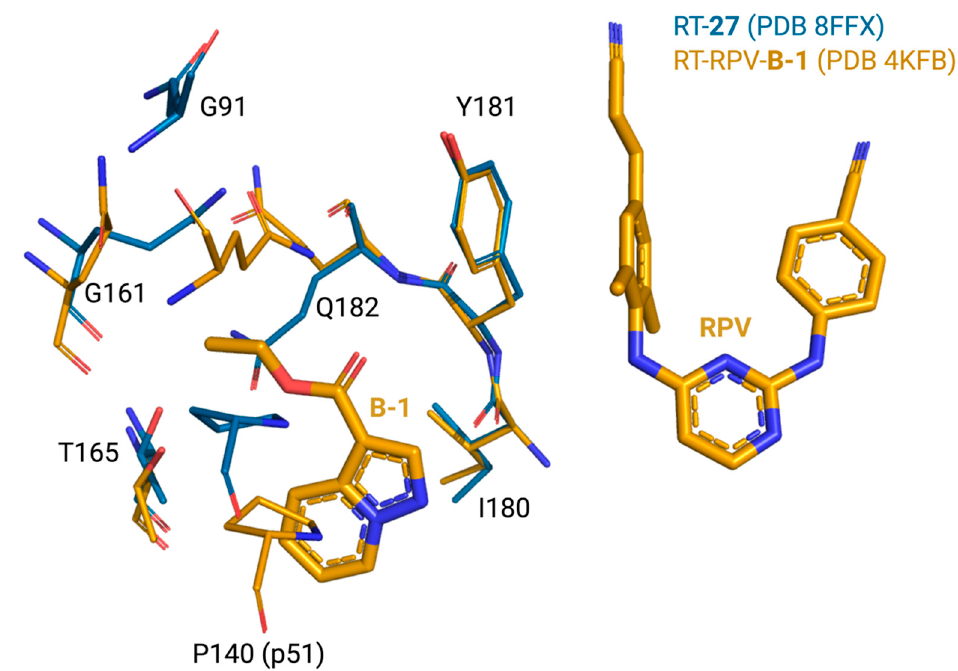
Figure 4. Comparison of the NNRTI Adjacent site of superposed RT- 27 (PDB ID 8FFX, blue) and RT-RPV- B-1 (PDB ID 4KFB, orange) structures. Rilpivirine (RPV) is depicted in the neighboring NNIBP (orange). Nitrogen atoms are blue and oxygen atoms are red.